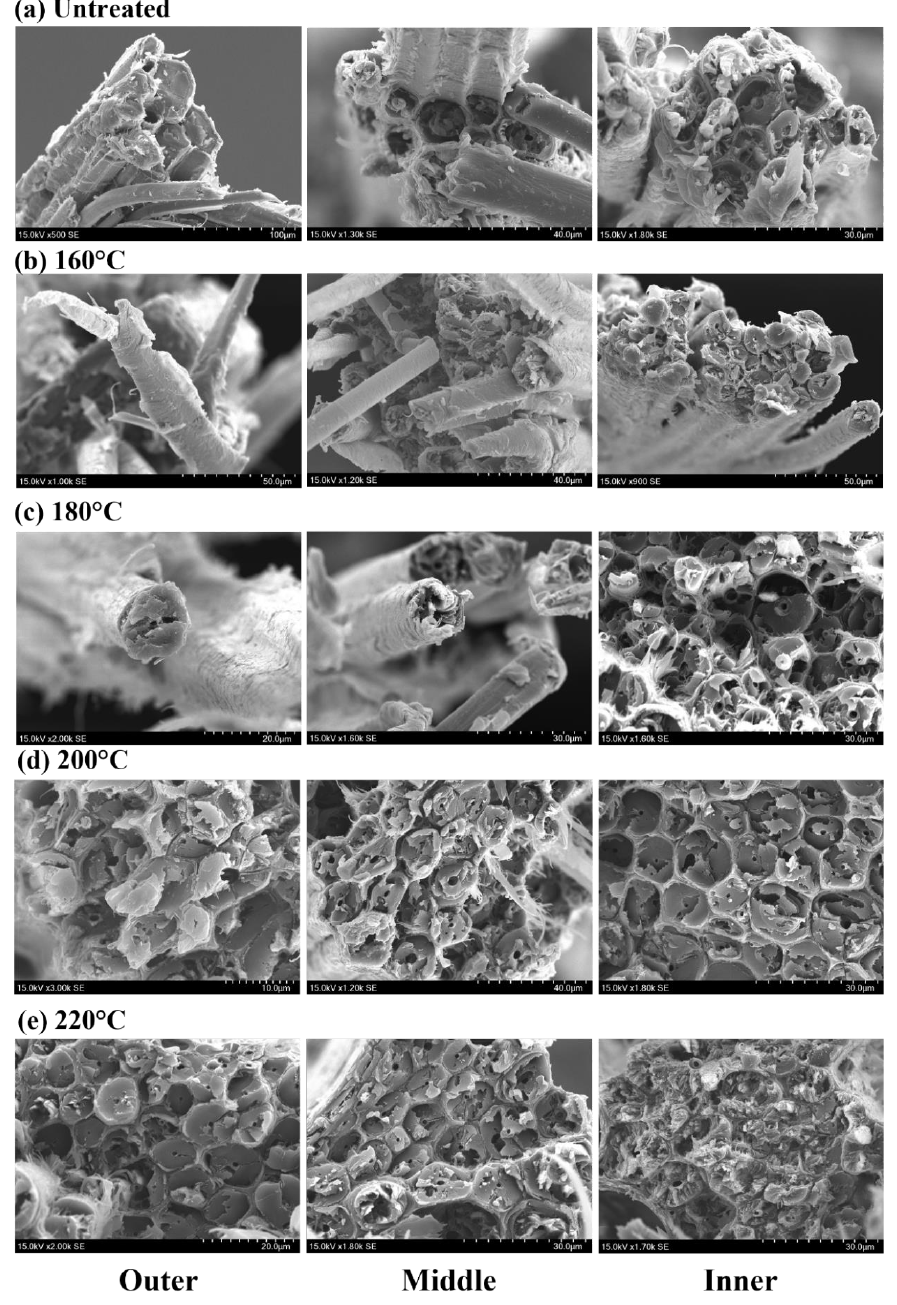
Figure 7. Overview of fracture surfaces of fibers in different areas in the radial direction with differ- ent